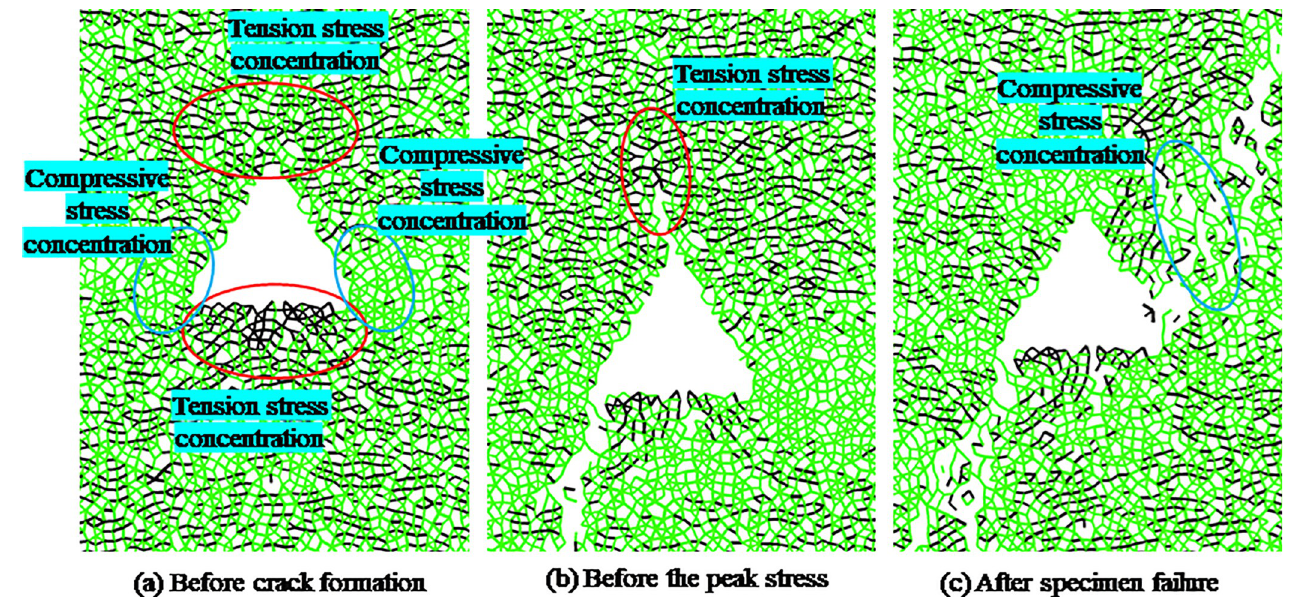
Fig 15. Stress chain diagram of rock model with triangular hole defect before and after crack